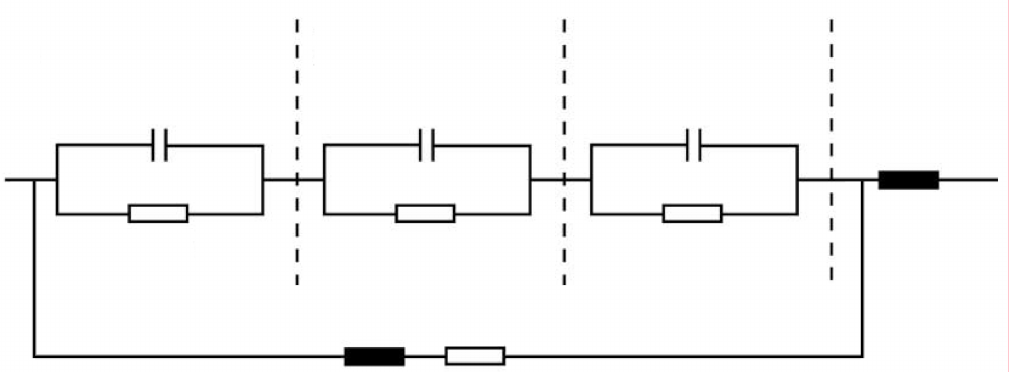
Figure 12. Equivalent circuit diagram of the measuring arrangement.